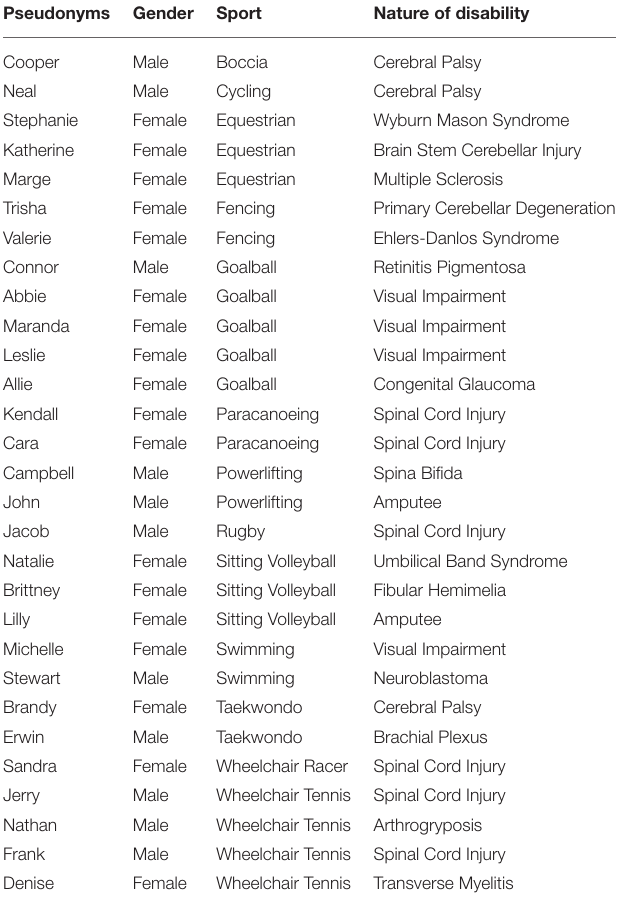
TABLE 1 | Demographic information of